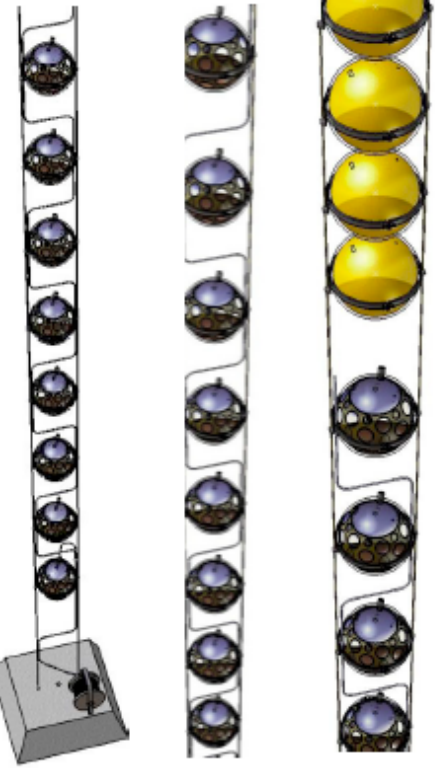
Fig. 9. Schematic layout of the String Detection Unit (from bottom at left to top at right).